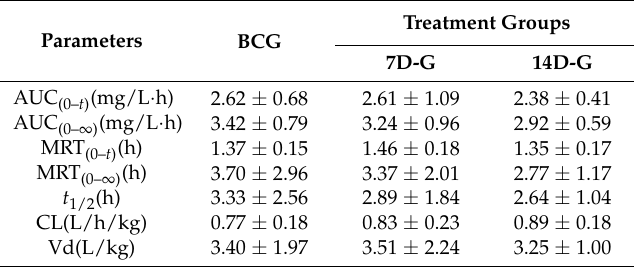
Table 1. Effects of Shenxiong glucose injection (SGI) on pharmacokinetic parameter of caffeine (1.0 mg/kg).